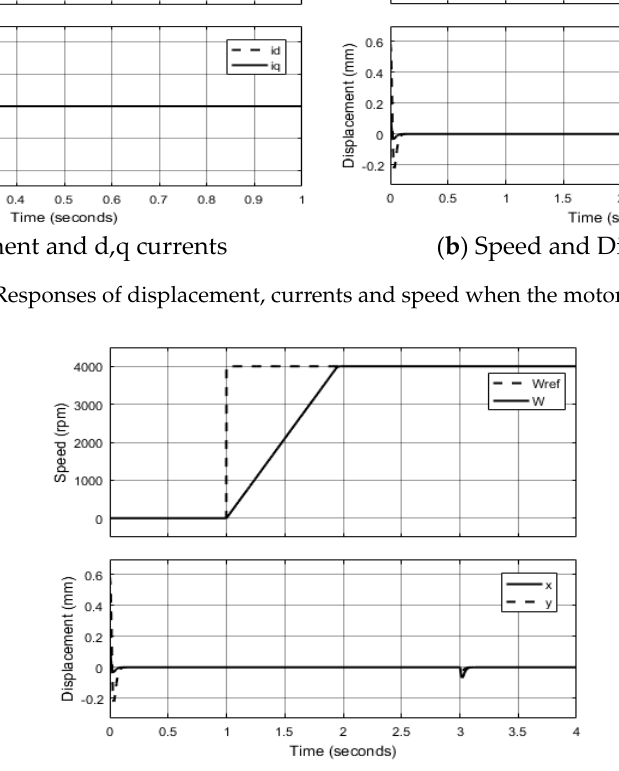
Figure 15. Influence of external impulse force.